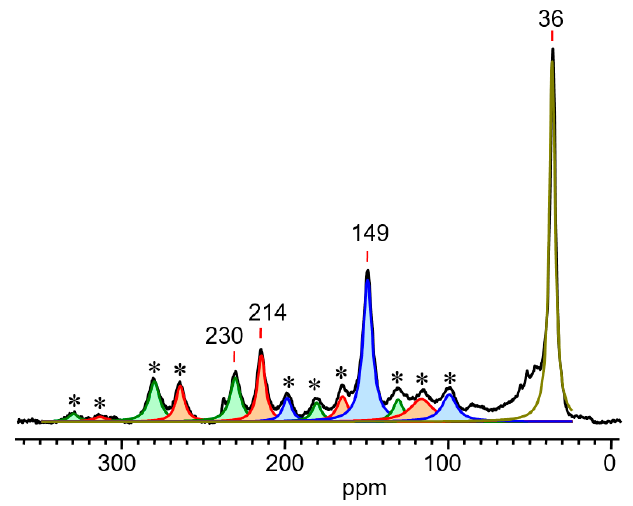
Figure 8. 13 C MAS NMR analysis with high ‐ power 1 H decoupling of the 13 C ‐ C 4 H 5+ {Cl 11 − } salt. Each signal and the corresponding spinning sidebands, marked with asterisk, have the same color.